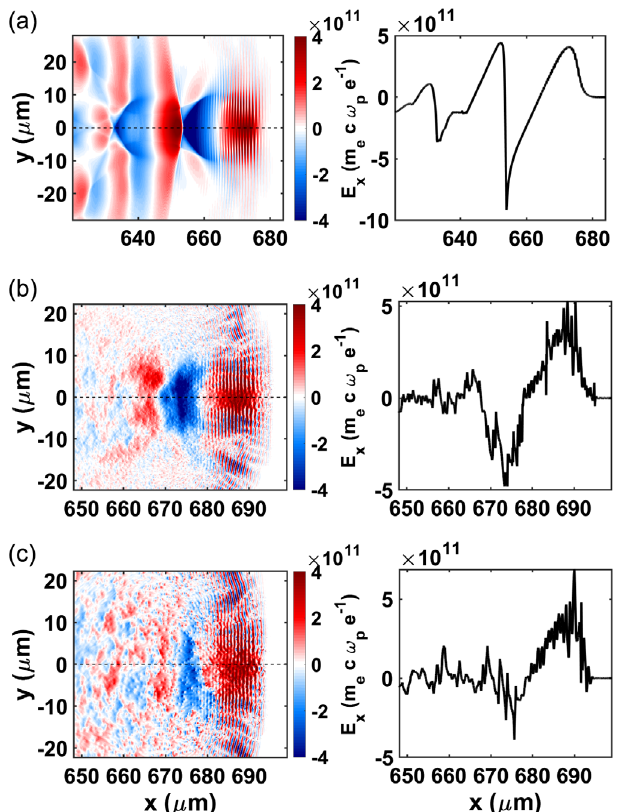
FIG. 3. Longitudinal electric field of simulations D (top row), E (middle row), and F (bottom row) — see Table I. The plots on the right show lineouts of the laser propagation axis at y ¼ 0 . The laser has propagated ∼ 0 . 7 mm within the